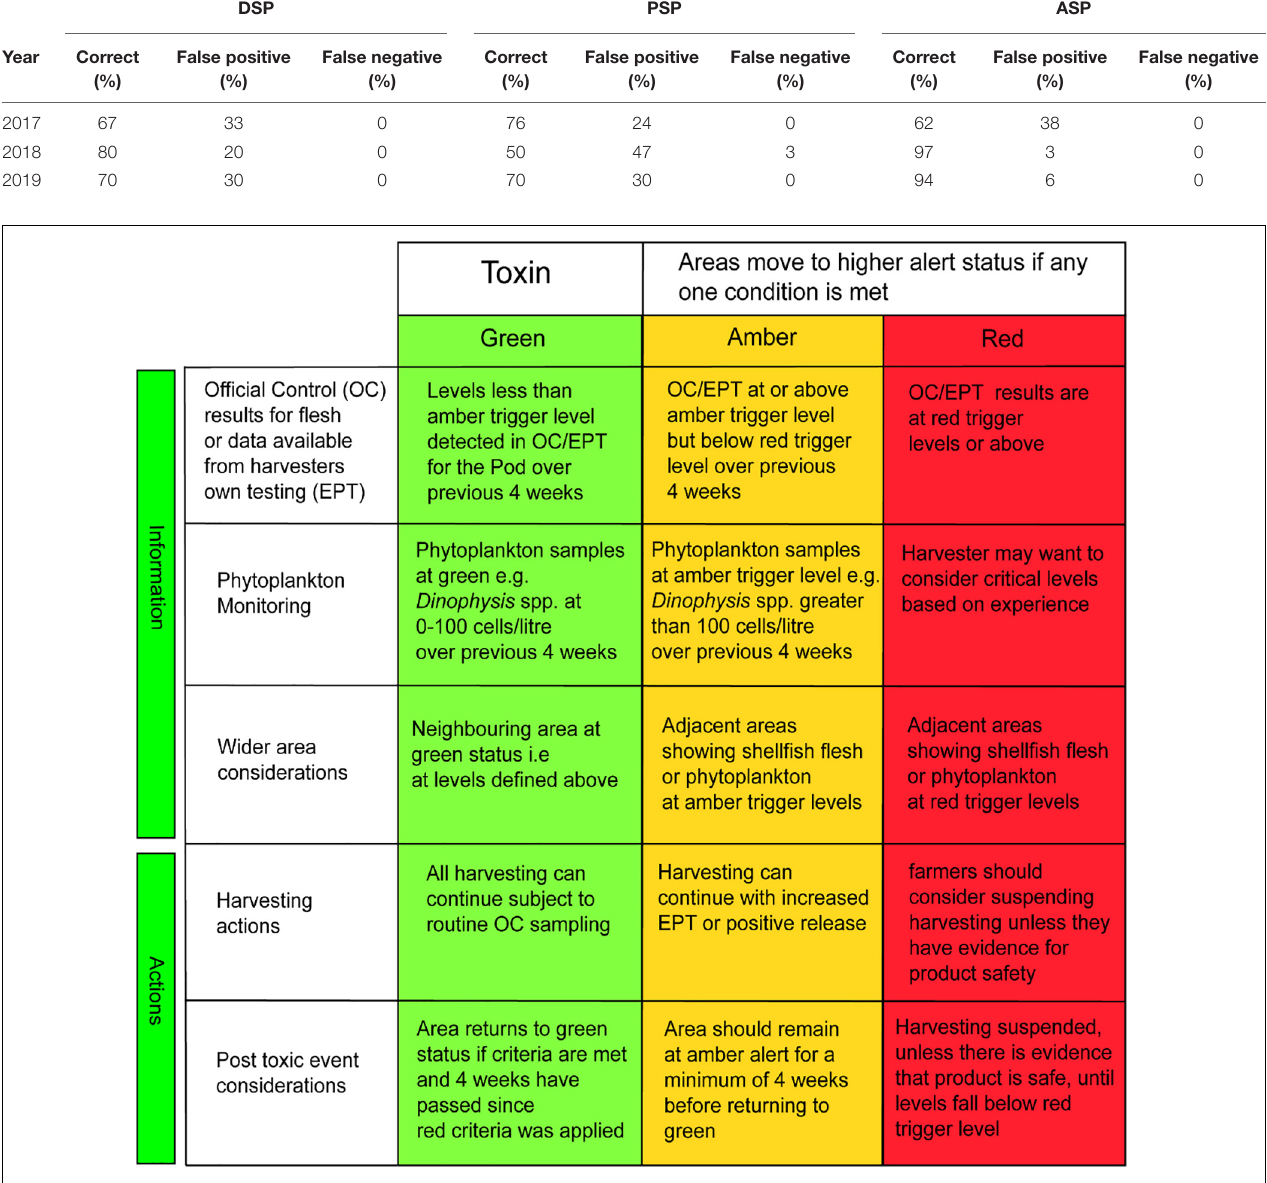
TABLE 1 | Expert interpretation success for the HABreports system 2017–2019.